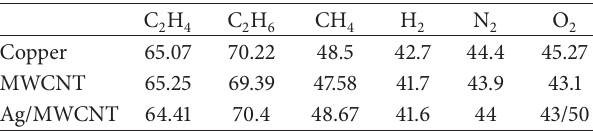
Table 1: Desorption temperatures